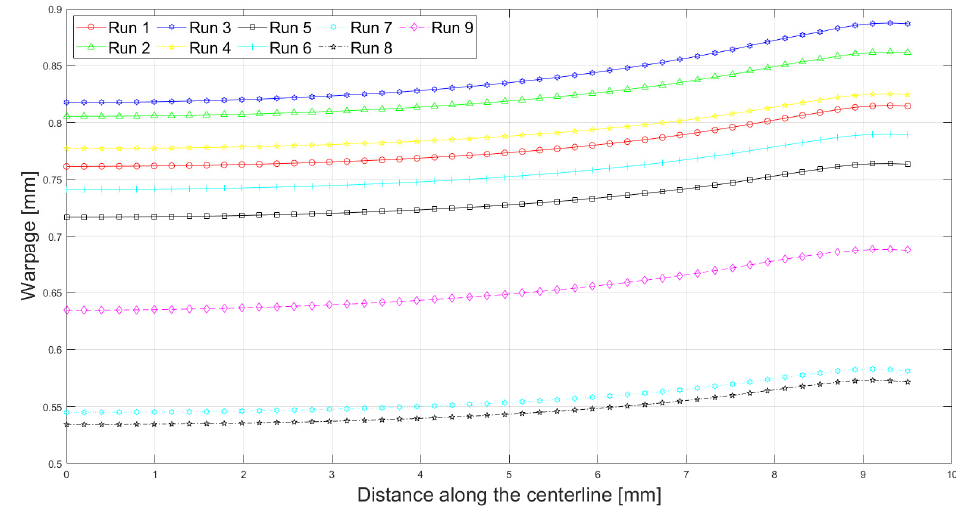
Figure 9. Warpage along the central half-width.